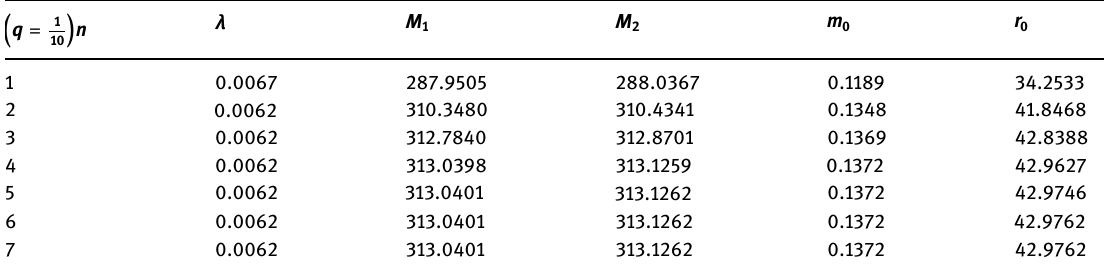
Table 1: Some numerical results of λ , M 1 , M 2 , m 0 , r 0 in Example 4.1 for ∈ t J and = q